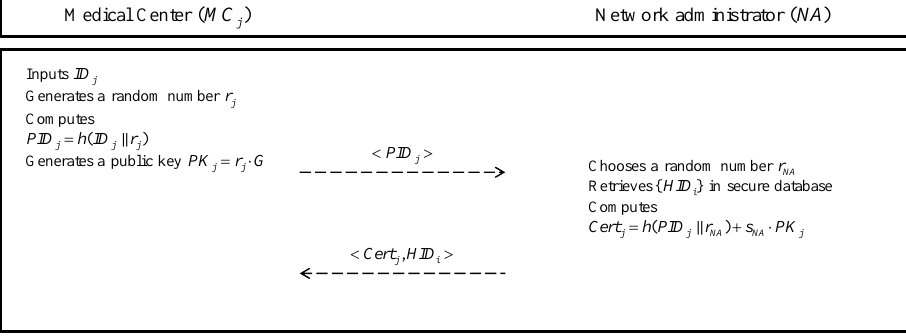
Figure 3. Medical center registration phase of the proposed